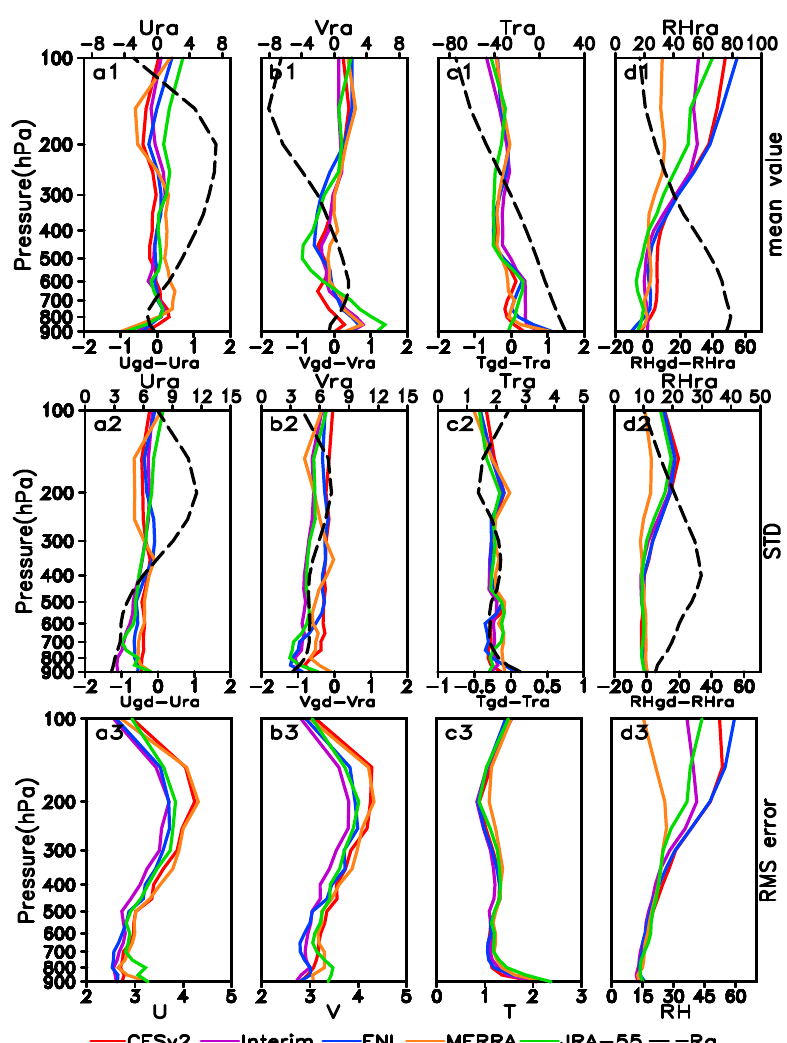
Figure 2. (Top row) Vertical profiles of mean difference (mean bias, color line) between radiosonde data ( U ra, V ra, T ra, RH ra; black dotted line) and gridded datasets (GDs) ( U gd, V gd, T gd, RH gd) in the basin ( a1 ) U (m/s), ( b1 ) V (m/s), ( c1 ) T (°C), ( d1 ) RH (%), all the data ae averaged over five independent radiosonde sites in the basin during late June to the end of July (2011–2015); (second row) Vertical profiles of difference between mean standard deviation (STD) between radiosonde data and GD ( a2 ) U , ( b2 ) V , ( c2 ) T , ( d2 ) RH for radiosonde and five GDs products; (bottom) Vertical profiles of the root-mean-square (RMS) errors for each of GDs verifying against the radiosonde data (radiosonde data) for ( a3 ) U , ( b3 ) V , ( c3 ) T , and ( d3 ) RH . CFSv2, Climate Forecast System Version 2; Interim, European Centre for Medium-Range Weather Forecasts Reanalysis Interim; FNL, NCEP Final Operational Global Analysis; MERRA, Modern Era Retrospective Analysis for Research and Applications; JRA-55, the Japanese 55 -year Reanalysis.